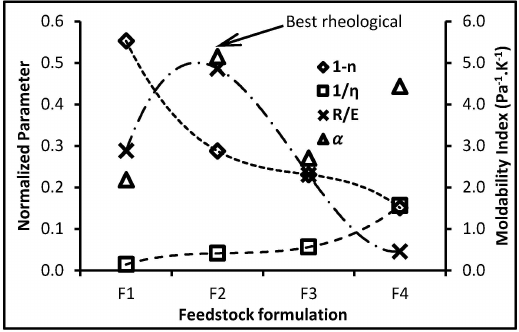
Figure 10. General moldability index vs. feedstock formulation.